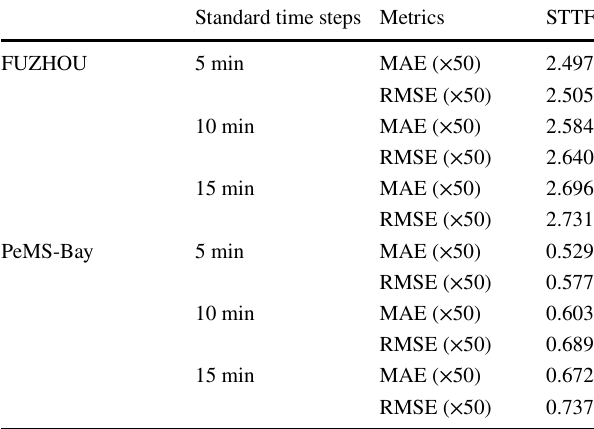
Table 5 Performance of STTF model with different time